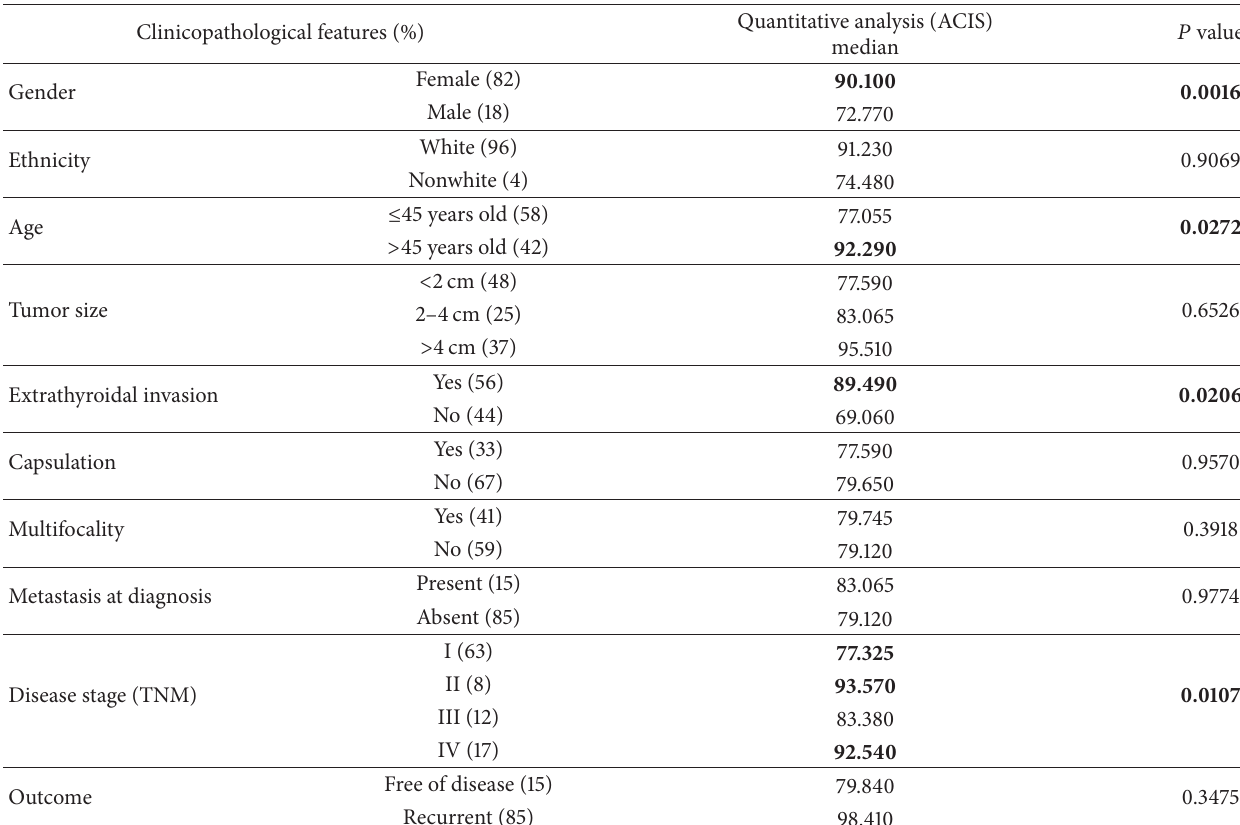
Table 2: Immunohistochemical expression of MAGE A3, according to clinicopathological features of aggressiveness, patient’s outcome, and immunological